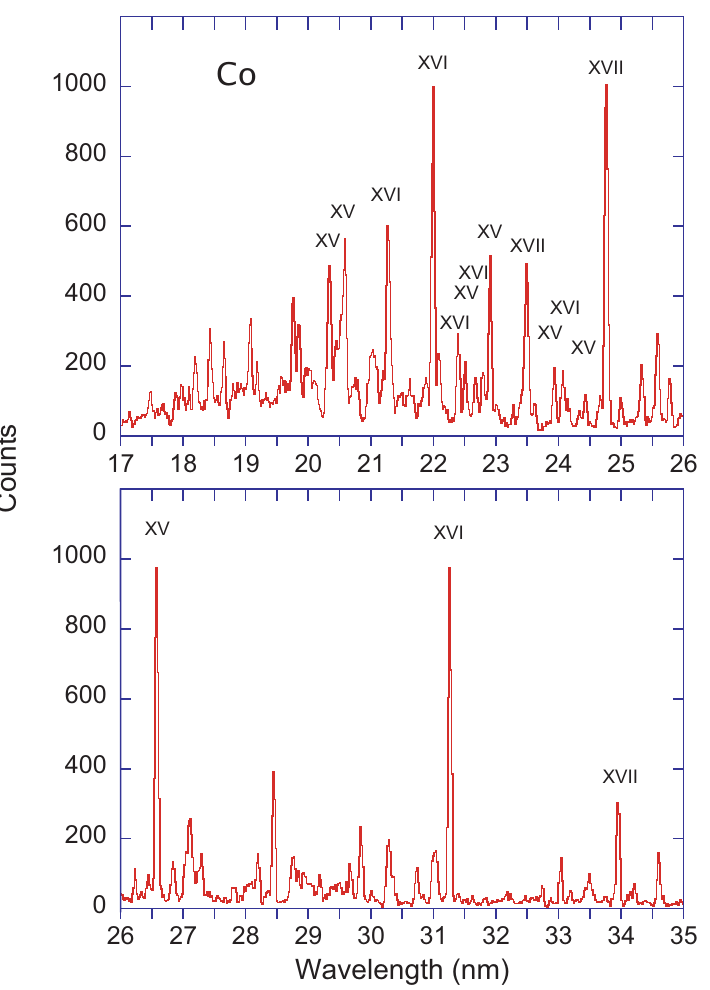
Figure 21. Beam-foil spectra of Co at an ion beam energy of 28MeV. Observation at the foil. Line width (FWHM) 0.06nm. The strongest lines are identified by the spectrum